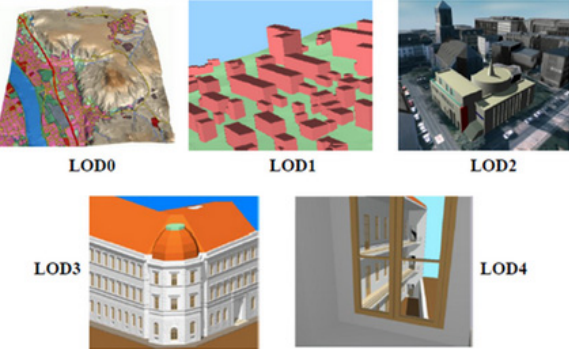
Figure 9. Different LoD in CityGML. Figure courtesy of